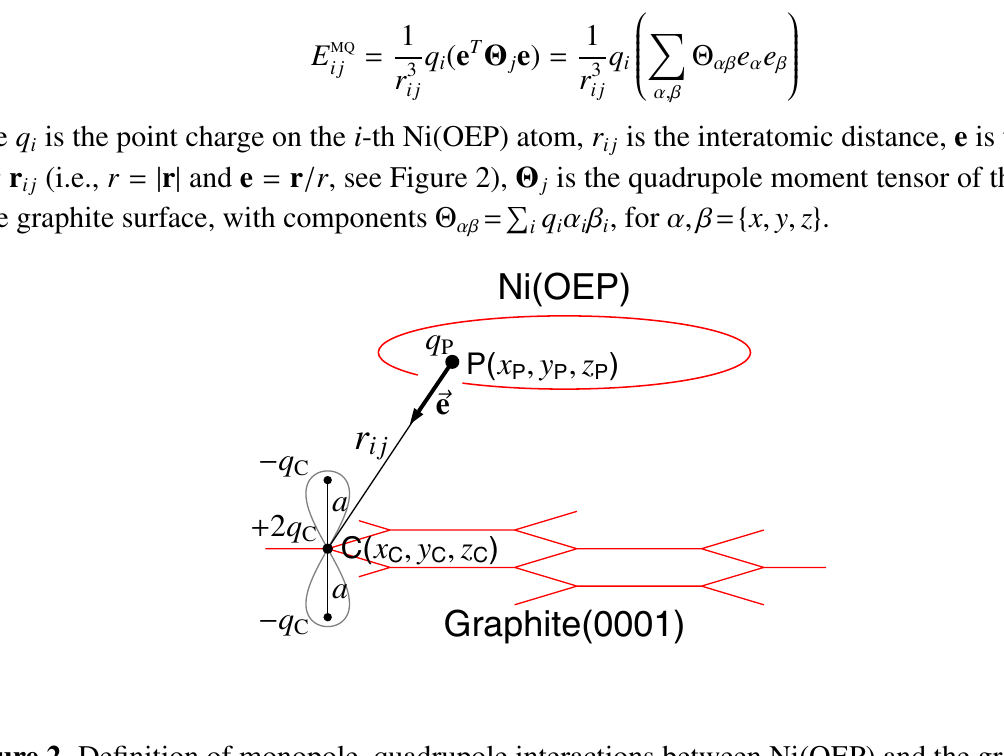
Figure 2 . Definition of monopole–quadrupole interactions between Ni(OEP) and the graphite(0001)